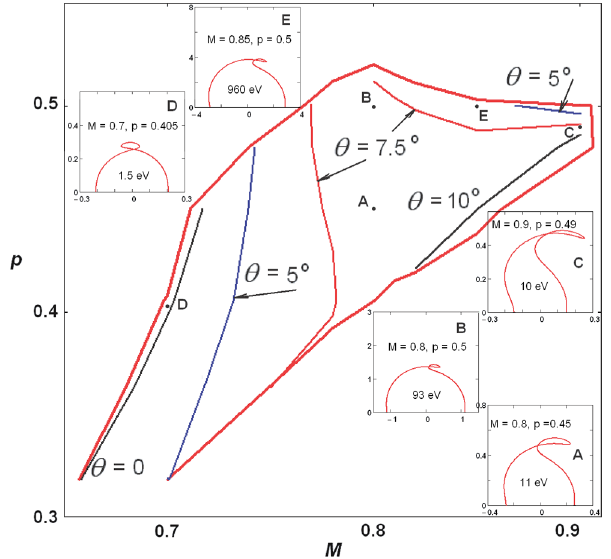
FIG. 9. Equatorial cross-field two-point second-order multi- pacting zone. FIG. 11. Incidence angle of the electrons in the second zone of the two-point multipactor. See explanations in Fig.